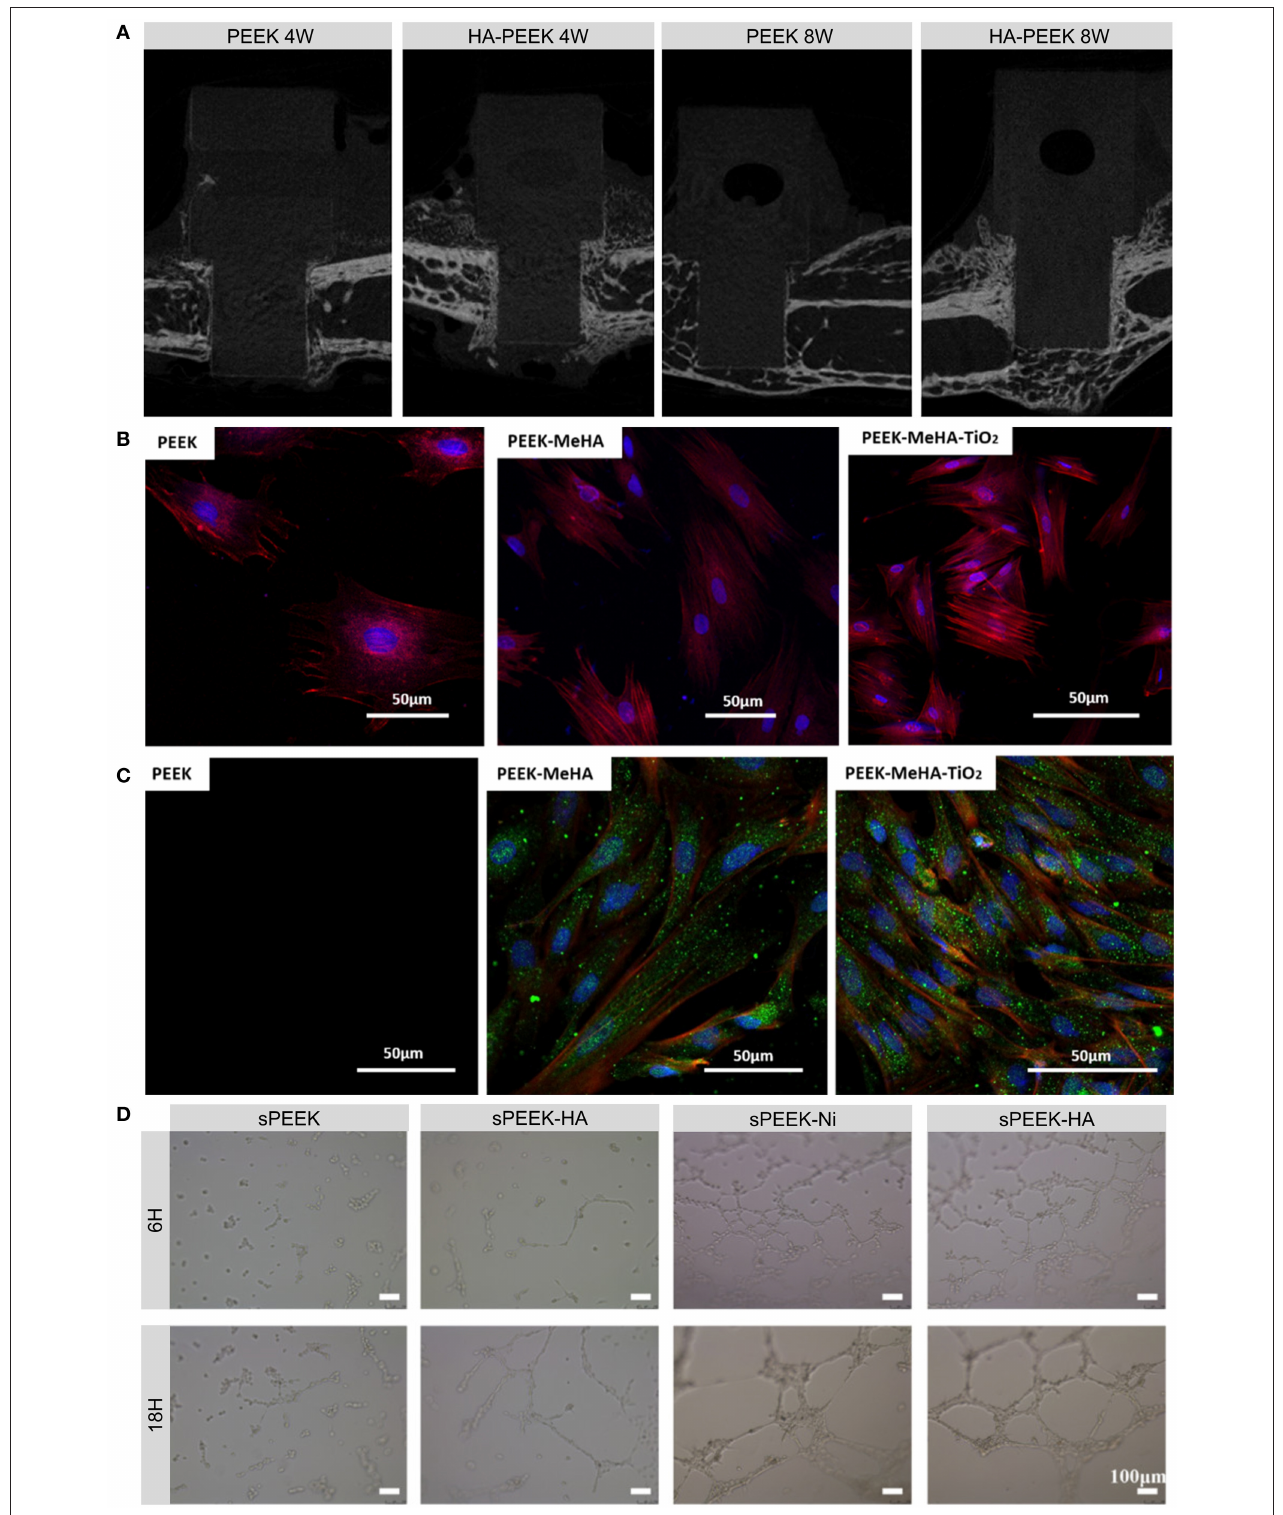
FIGURE 2 | Examples and biological effects of modifications inspired by the components of bone. (A) Micro-CT images of new bone formed on HA-coated PEEK and on uncoated PEEK at 4 and 8 weeks after implantation. (B) Fluorescence micrographs of actin (red) and nucleus (blue) in rBMSCs grown on PEEK, PEEK-MeHA, and